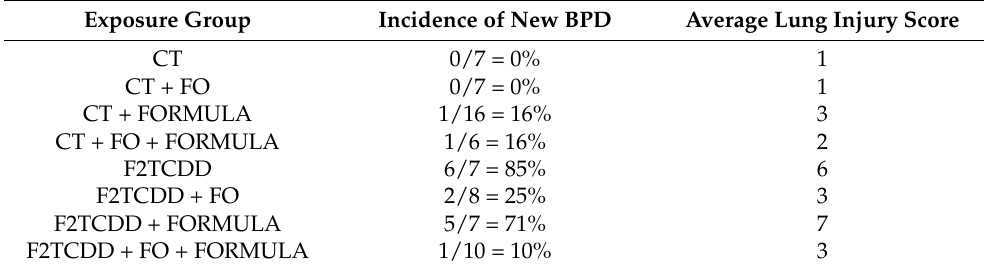
Figure 4. A dietary fish oil intervention reduces the incidence of BPD in TCDD-exposed pups: Incidence of BPD was determined in CT and F2TCDD pups ± a fish oil intervention and/or formula supplementation ( A ), the incidence of BPD was determined using a novel scale based on lung histology ( B – G ). Data points represent the individual lung injury scores of 6–10 non-littermates from each group. Standard deviation is shown. **** p ≤ 0.0001. Table 1. Incidence of pups with BPD across all groups. CT, control; FO, fish